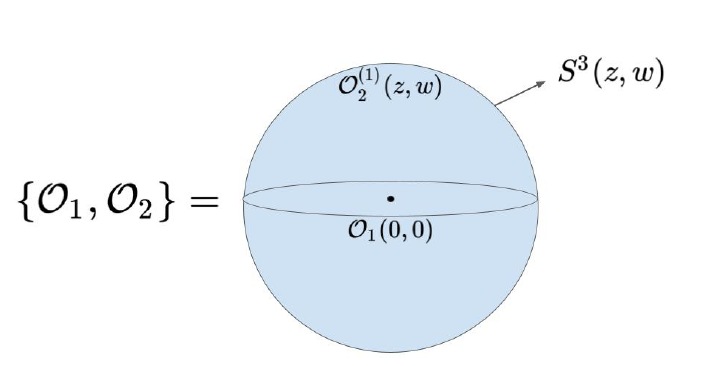
Figure 2: It illustrates a product between the first and second-type operators. We place O at the origin and wrap it with Ω O 1 S 3 , parametrized by z , w